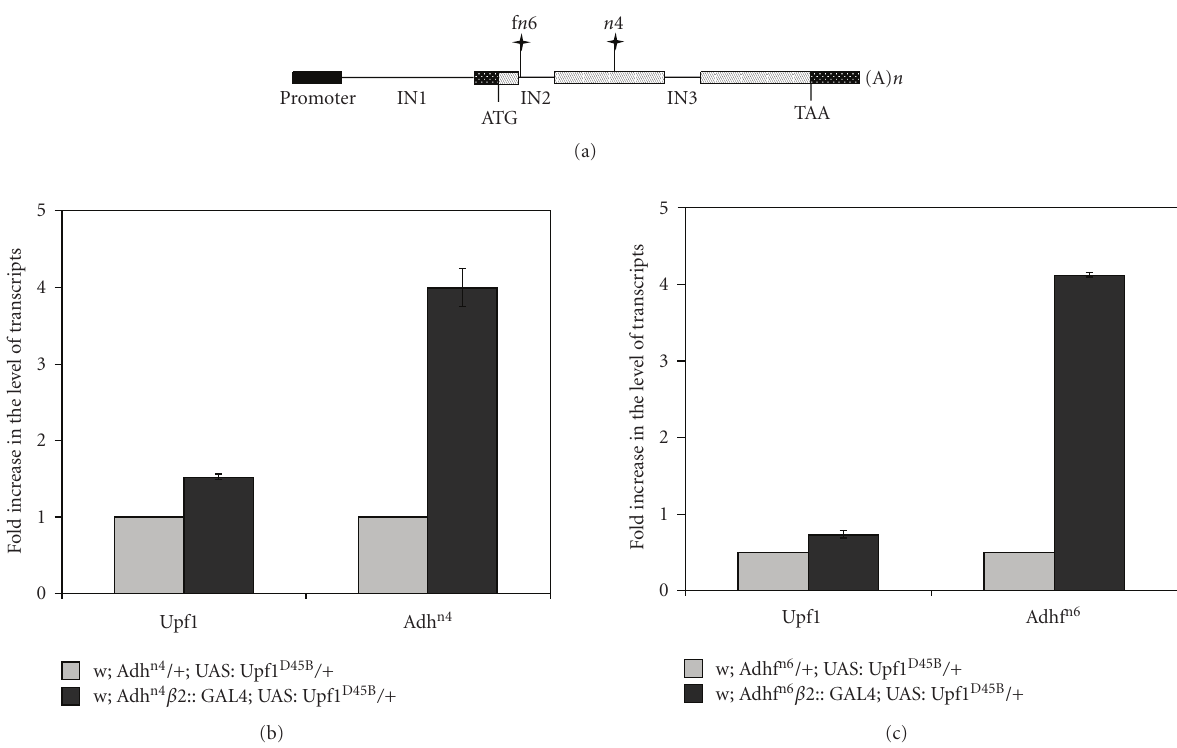
Figure 1: Schematic map of the Adh gene. (a) Rectangles represent exons; black box represents promoter region; hatched boxes indicate coding regions; punctated boxes represent untranslated regions. The horizontal lines represent introns, IN1-IN3. The position of the mutations are indicated with vertical lines marked with a star; Adh fn 6 is the mutation a ff ecting splicing while Adh n 4 is a nonsense mutation. (b) and (c) Compared levels of Adh and Upf1 transcripts in flies that were heterozygous for Adh alleles and for Upf1 D 45 B . A 3.8- and 8.8-fold accumulation of nonsense-containing Adh mRNA was observed in w 1118 ; Adh n 4 / β 2::GAL4 ; UAS :Upf1 D 45 B /+ and w 1118 ; Adh fn 6 /β 2::GAL4 ; UAS :Upf1 D 45 B /+ mutant flies with respect to the endogenous levels of Adh and Upf1 control mRNAs. The experiment was repeated three